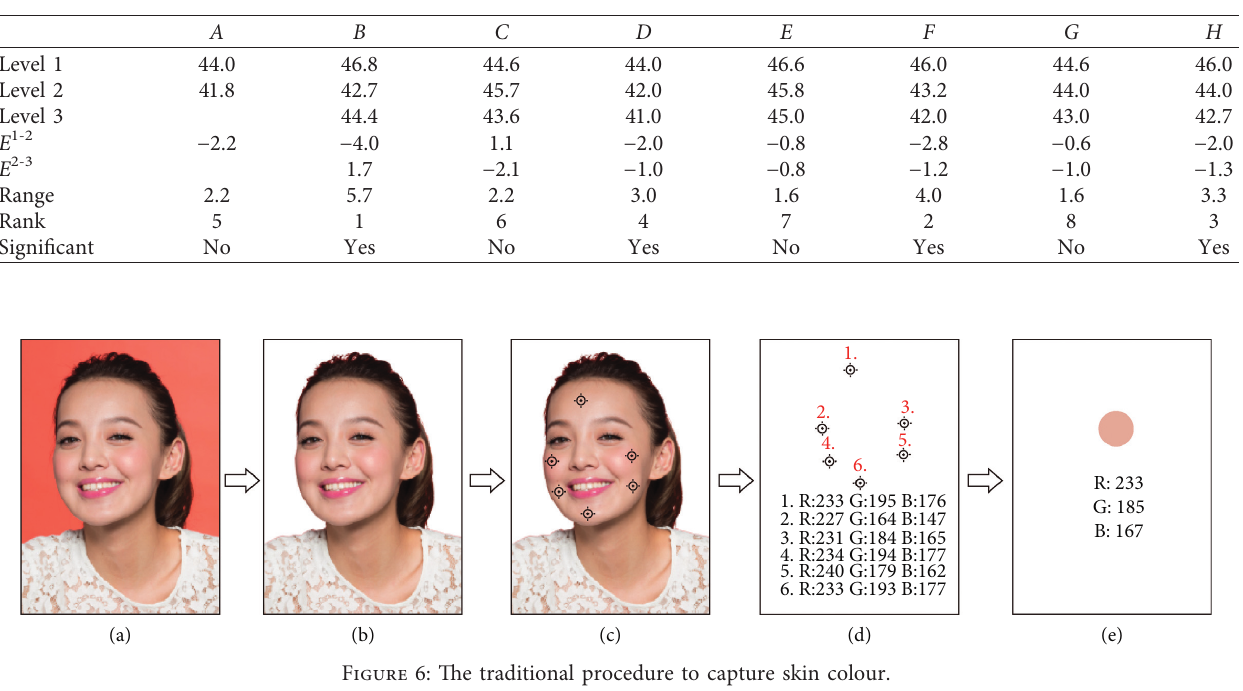
Table 3: Factor characteristics result table.